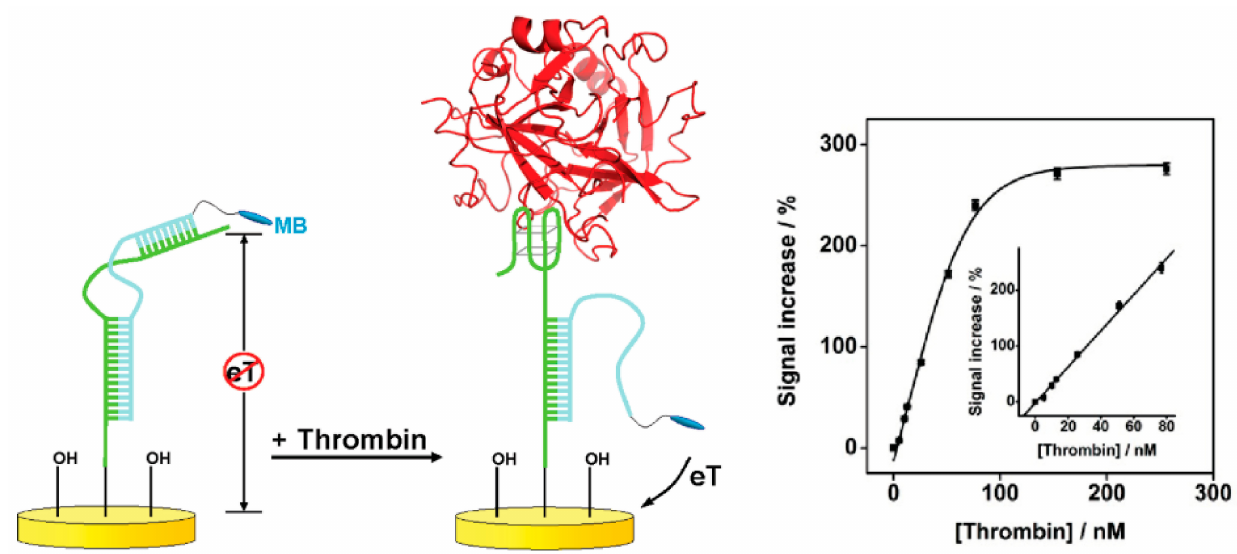
Figure 2. The schematic representation of the “signal-on” strategy involving a MB-tagged cDNA thrombin aptamer immobilized on a gold surface: upon target binding the aptamer undergoes conformational folding that loosens the tagged end of the cDNA, which approaches the electrode surface and generates a detectable redox current. Reprinted with permission from [112]. Copyright 2010 American Chemical Society.